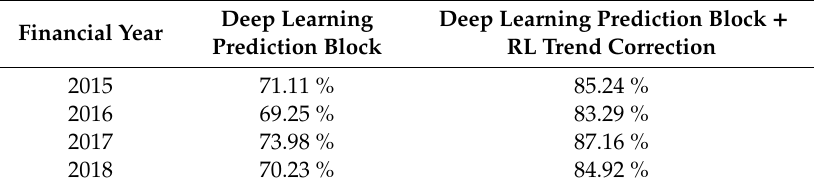
Table 1. Trend forecast performance accuracy for \ EUR / USD